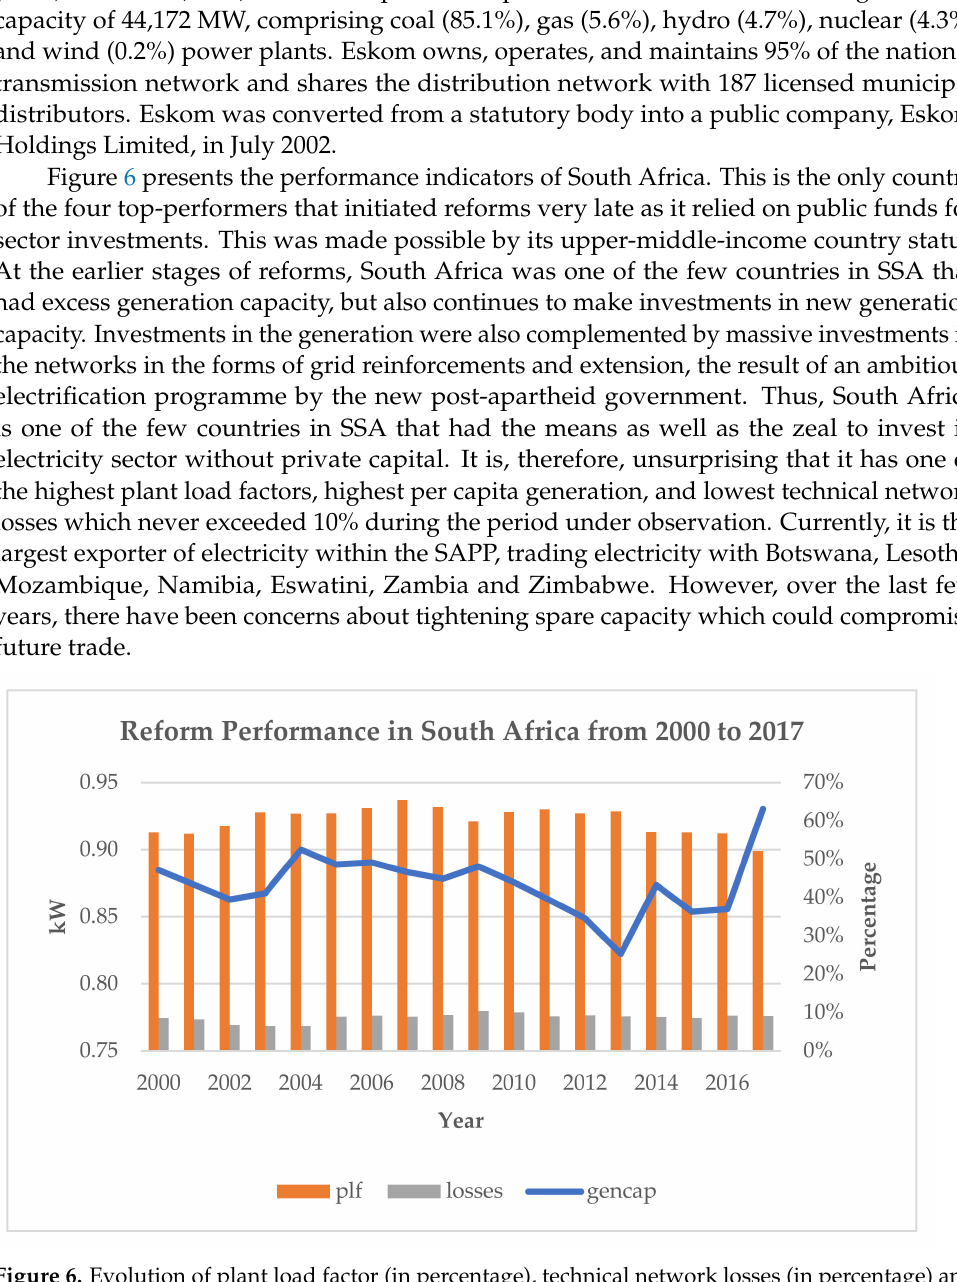
Figure 6. Evolution of plant load factor (in percentage), technical network losses (in percentage) and installed generation capacity per capita (in kilowatt) in South